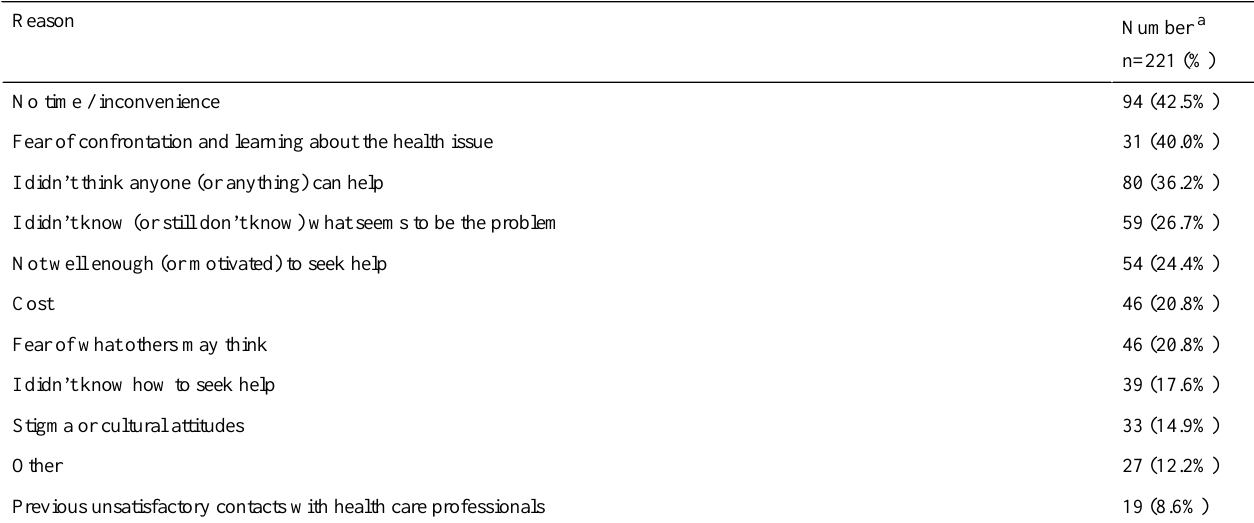
Table 5. Reasons for not seeking help for emotional well-being concerns during study